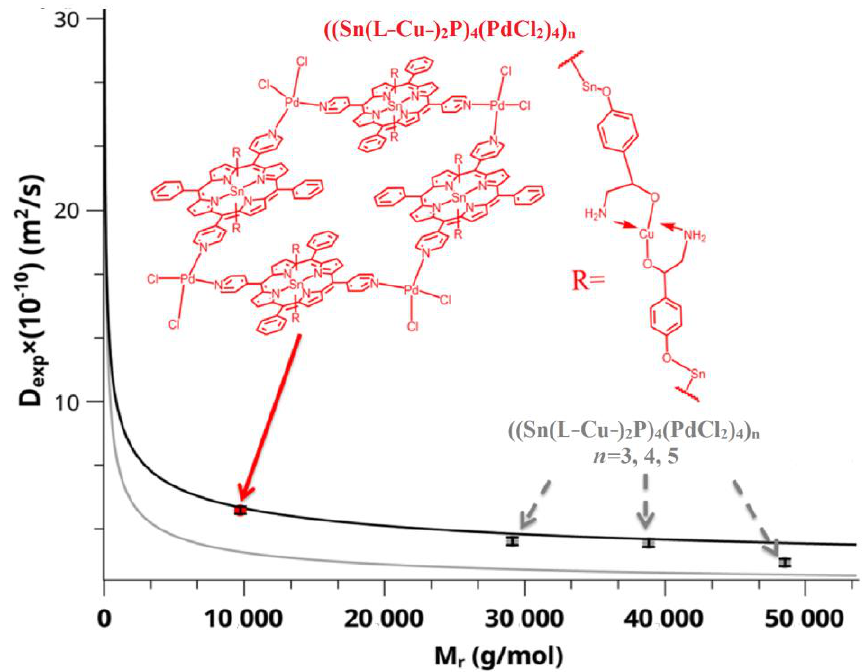
Figure 5. Graphical analysis of self-diffusion coefficients versus molecular weight from DOSY NMR spectroscopy. The red dot is the dimeric structure of the complex ((Sn(L-Cu-) 2 P) 4 (PdCl 2 ) 4 ) n , the gray dots are the probable structure of the complex formed from several monomer